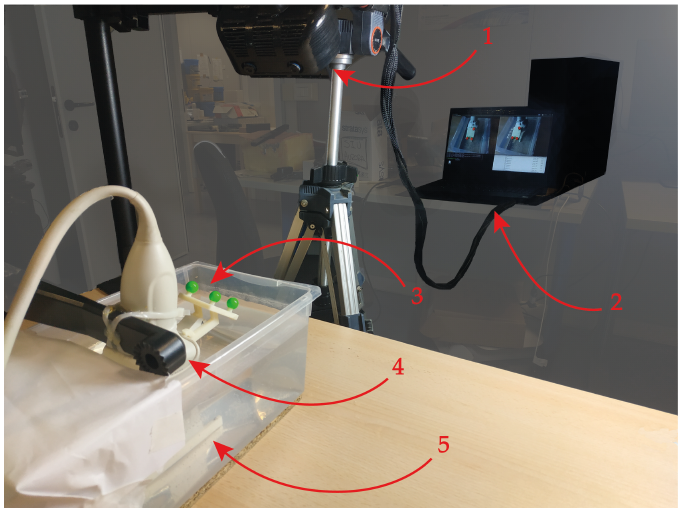
Figure 5. Set-up implemented for the calibration: 1 → The augmented reality head-mounted display employed. 2 → The laptop running the RGB tracking algorithm. 3 → The optical frame anchored to the ultrasound probe. 4 → The mounting arm holding the ultrasound probe, which enables it to be moved in space. 5 → The calibration comb dipped in the 37° water